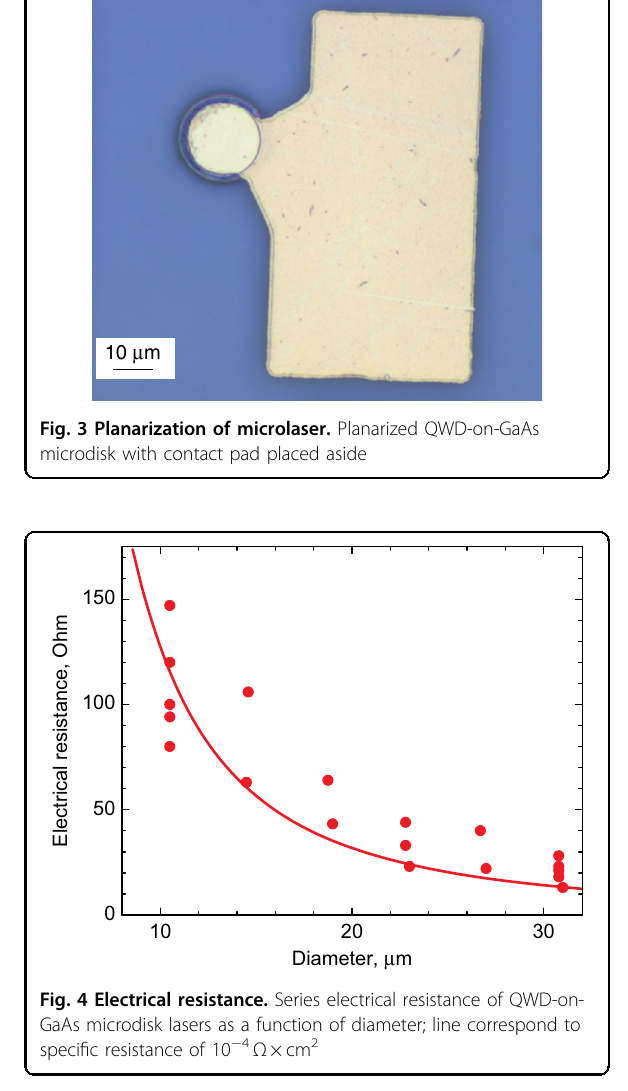
ffiffiffiffiffiffiffiffiffiffiffi p ρ = ð π D Þ , which notice- r disk